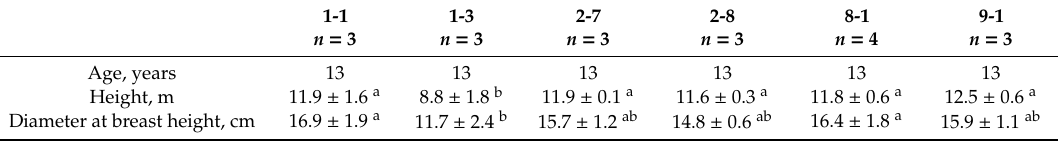
Table 1. Means and standard deviations (SD) in height and DBH of six C. bungei